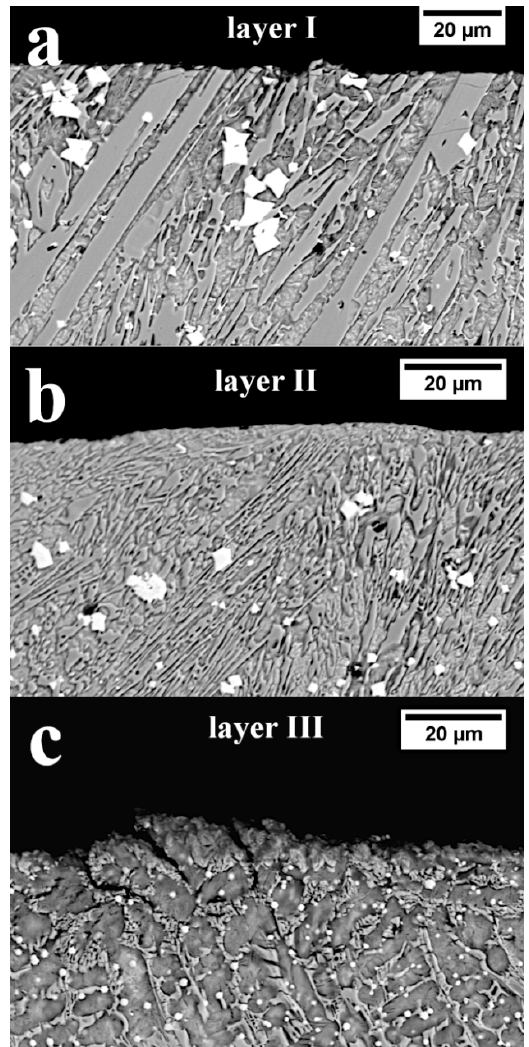
Figure 15. Cross-section of claddings produced by welding after operating in soil. ( a ) Layer I: no visible hardened layer during wear. Visible cracks of primary M 7 C 3 , indicated with an arrow ( b ) Layer II: visible slight hardened layer during wear. ( c ) Layer III: visible hardened layer and cracks in interdendritic spaces. Scanning electron microscopy.